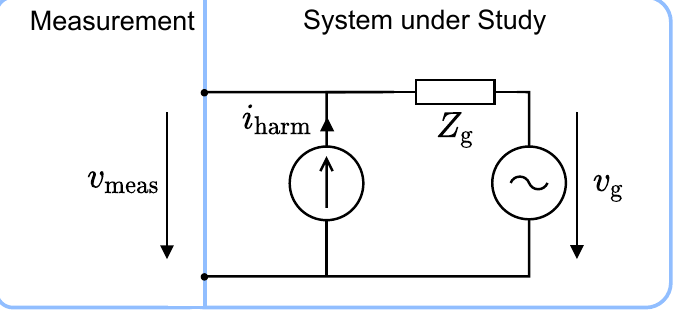
Figure 7. Base scenario without excitation.